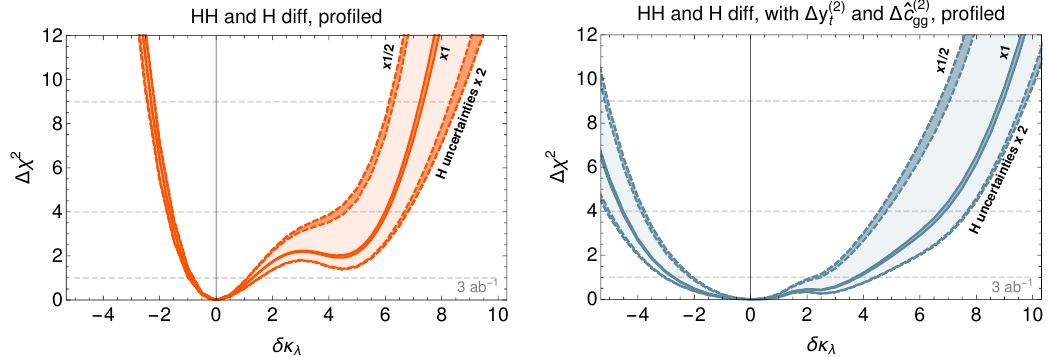
Figure 6 . Band of variation of the global (cid:12)t on the Higgs self-coupling obtained by rescaling the single-Higgs measurement uncertainties by a factor in the range x 2 [1 = 2 ; 2]. The lighter shaded bands show the full variation of the (cid:12)t due to the rescaling. The darker bands show how the (cid:12)ts corresponding to the ‘optimistic’ and ‘pessimistic’ assumptions on the systematic uncertainties (compare (cid:12)gure 5) change for x = 1 = 2 ; 1 ; 2. The left panel shows the (cid:12)t in the linear Lagrangian, while the right panel corresponds to the non-linear case in which (cid:1) y (2) independent